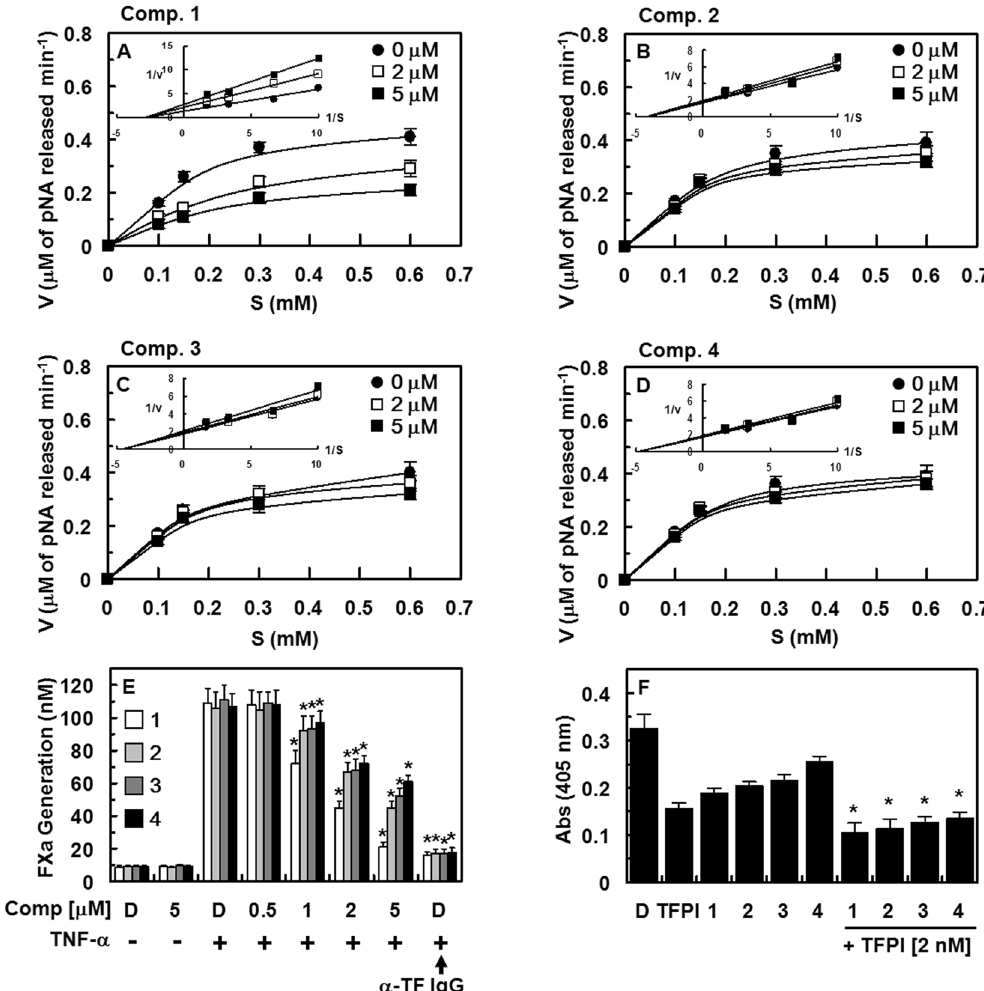
Figure 6. Effects of compounds 1–4 on inhibition and production of FXa. ( A–D ) Michaelis-Menten and Lineweaver-Burk plots (inset) for compounds 1 ( A ), 2 ( B ), 3 ( C ), and 4 ( D ) in PBS at pH 8.34 and 37 °C, demonstrating a noncompetitive inhibition of each compound. The plots represent means of three independent measurements. ( E ) Human umbilical vein endothelial cells (HUVECs) were pre-incubated with the indicated concentration of each compound for 10 min. HUVECs stimulated with tumor necrosis factor- α (TNF- α , 10 ng/mL for 6 h) were incubated with FVIIa (10 nM) and FX (175 nM) in the absence or presence of anti-TF IgG (25 µ g/mL). FXa production was determined as described in the “ Supplementary Materials and Methods” section. D = 0.2% DMSO used as the vehicle control. ( F ) Inhibition of FXa by each compound (5 μ M) with or without TFPI (2 nM) was monitored using a chromogenic assay. * p < 0.05 vs. TNF- α alone ( E ) or each compound ( F ) alone, analyzed via one-way ANOVA, followed by Tukey multiple comparison